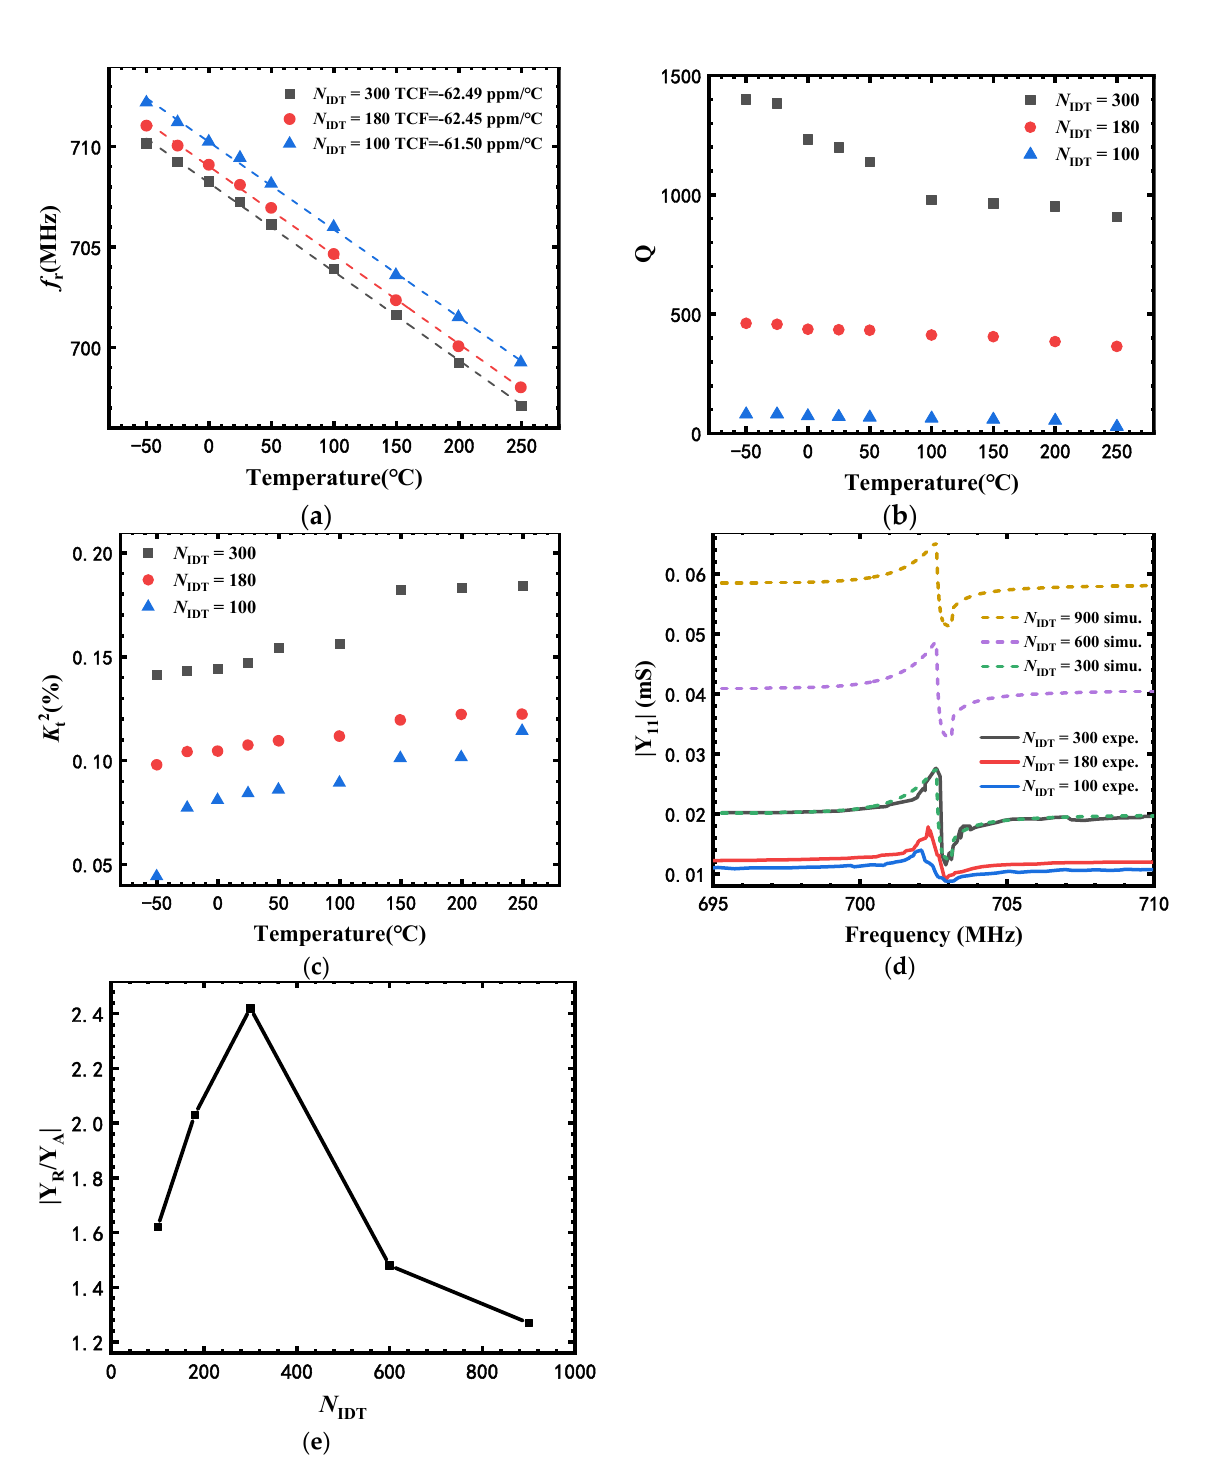
Figure 5. Temperature dependency of ( a ) f r , ( b ) Q, and ( c ) K 2 of sensors with different N IDT ; ( d ) admittance of SAW resonators with N IDT of 100, 180 and 300 (experimental results), and with N IDT of 300, 600 and 900 (simulated results); ( e ) ratio of conductance at resonant frequency and anti-resonant frequency ( Y r / Y a ) with different N IDT .